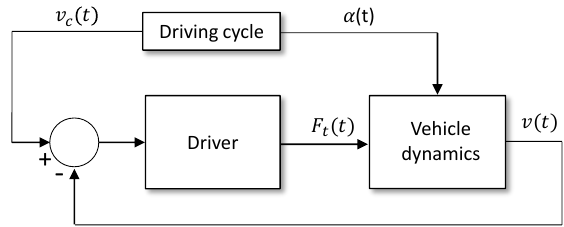
Figure 4. Lossless